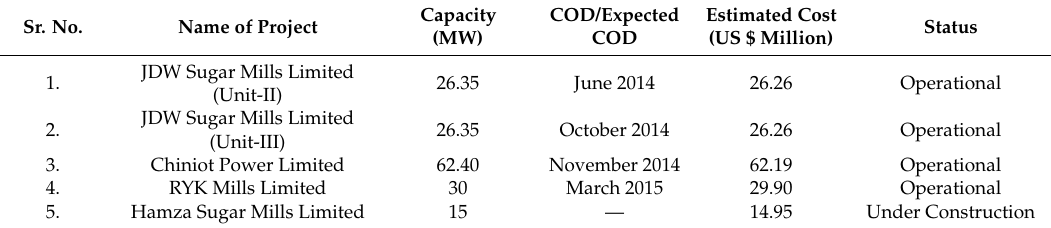
Table 19. Status of existing projects (in operation and under construction).